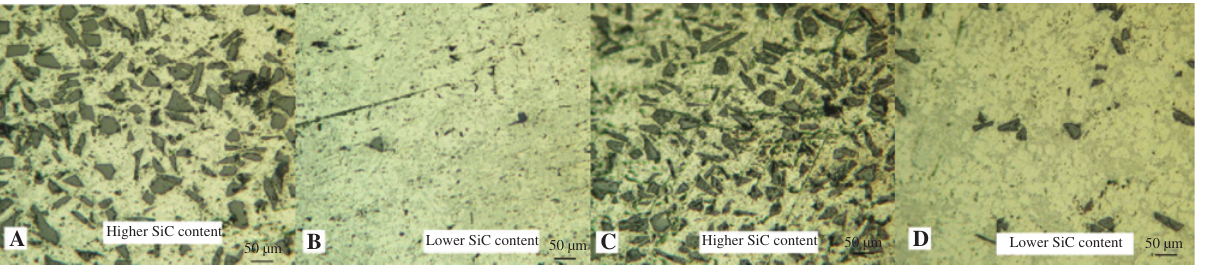
Figure 32: Optical micrographs of the FGMs processed under 1500 rpm (A, B) and under 2000 rpm (C, D) [99].